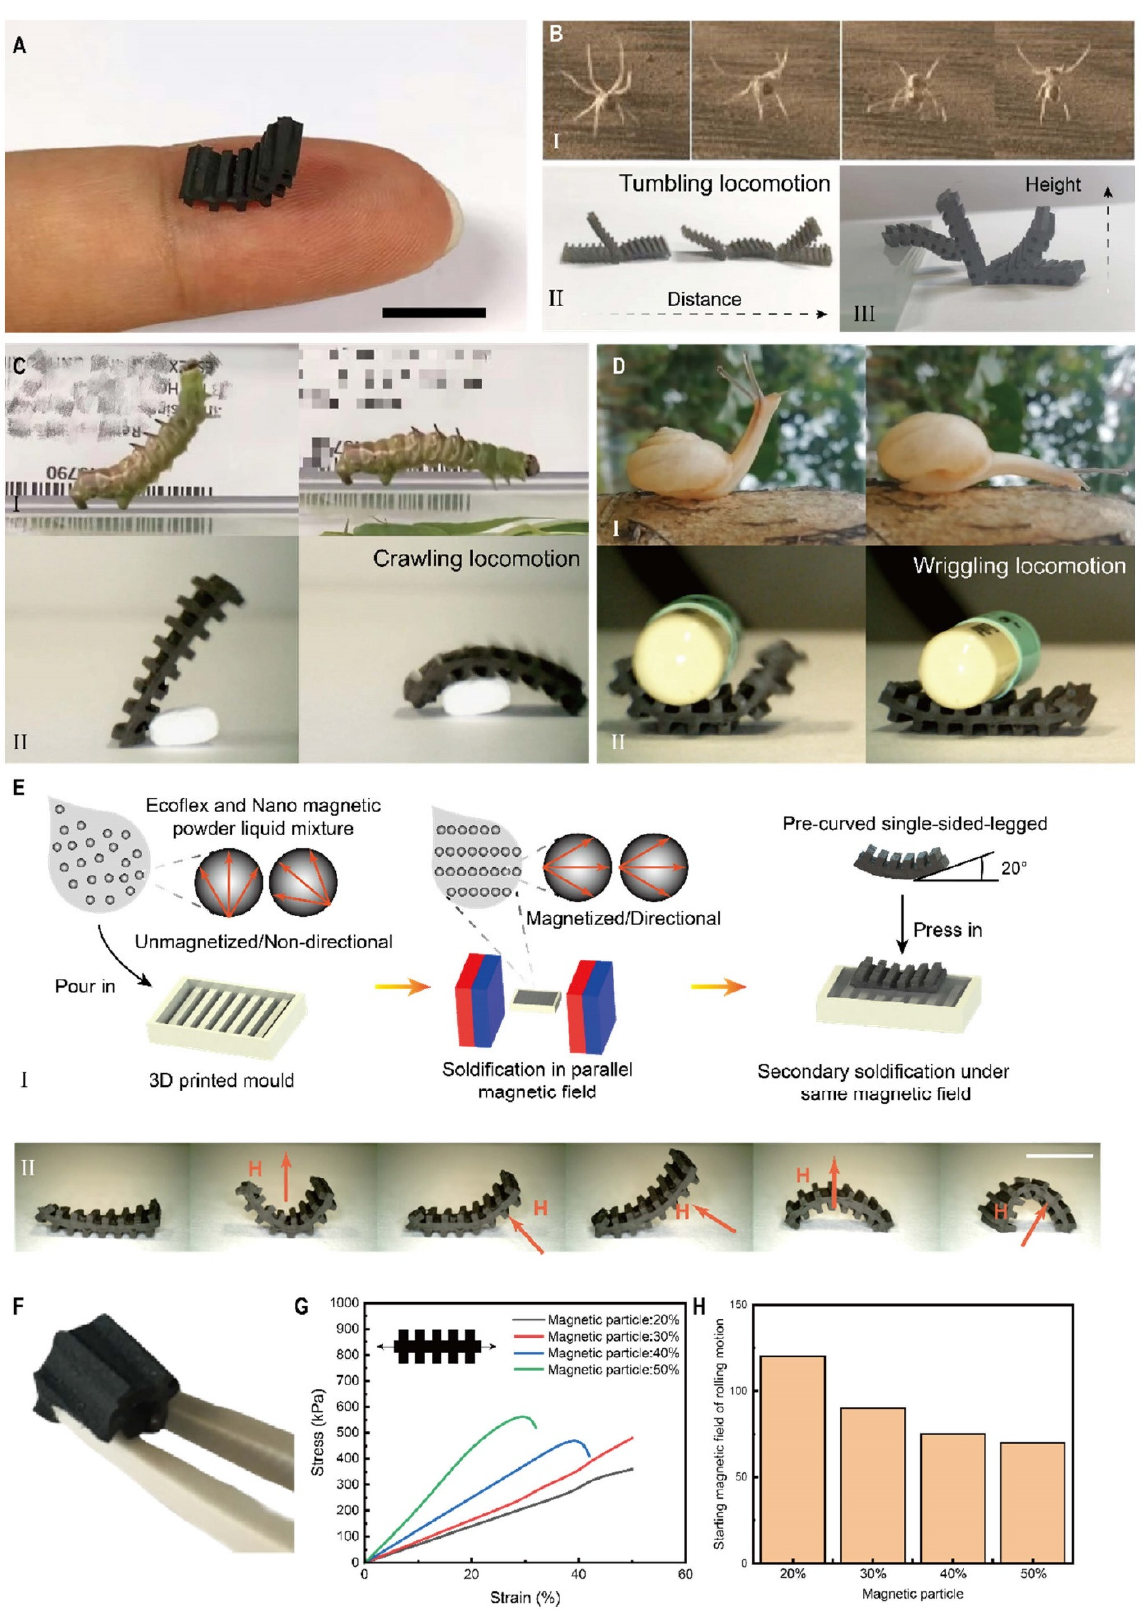
Figure 1. Insect-inspired soft robot with multimodal locomotion modes. ( A ) The robot moves through a finger (scale bar: 10 mm). ( B ) A tumbling locomotion that mimics the movement of a spider, allowing for displacement and overturning heights: (I) the rolling motion of spiders, by